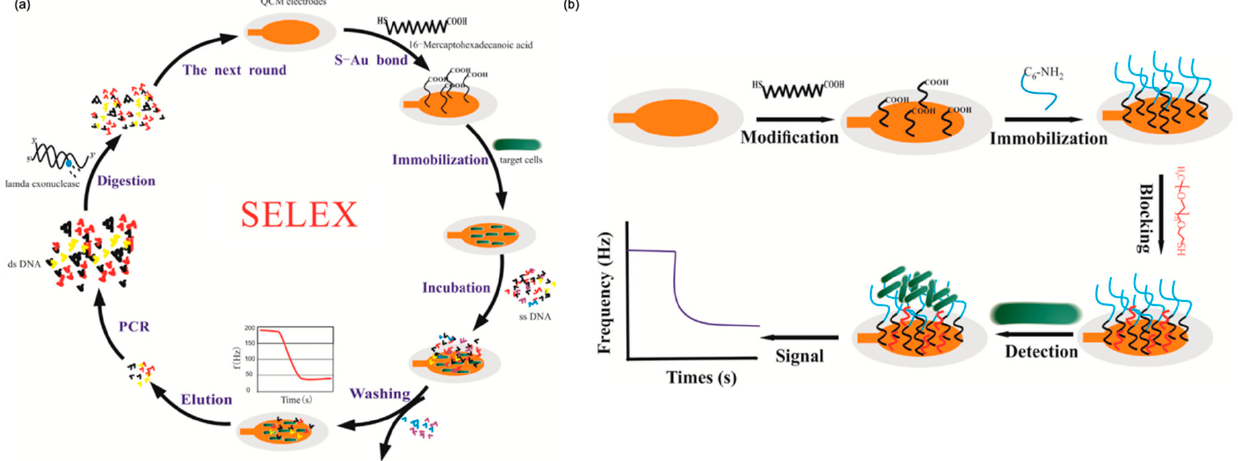
Figure 6. ( a ) SELEX process of DNA aptamers; ( b ) preparation of the QCM aptasensor. Reprinted with permission from Ref. [106] 2017, Wang.